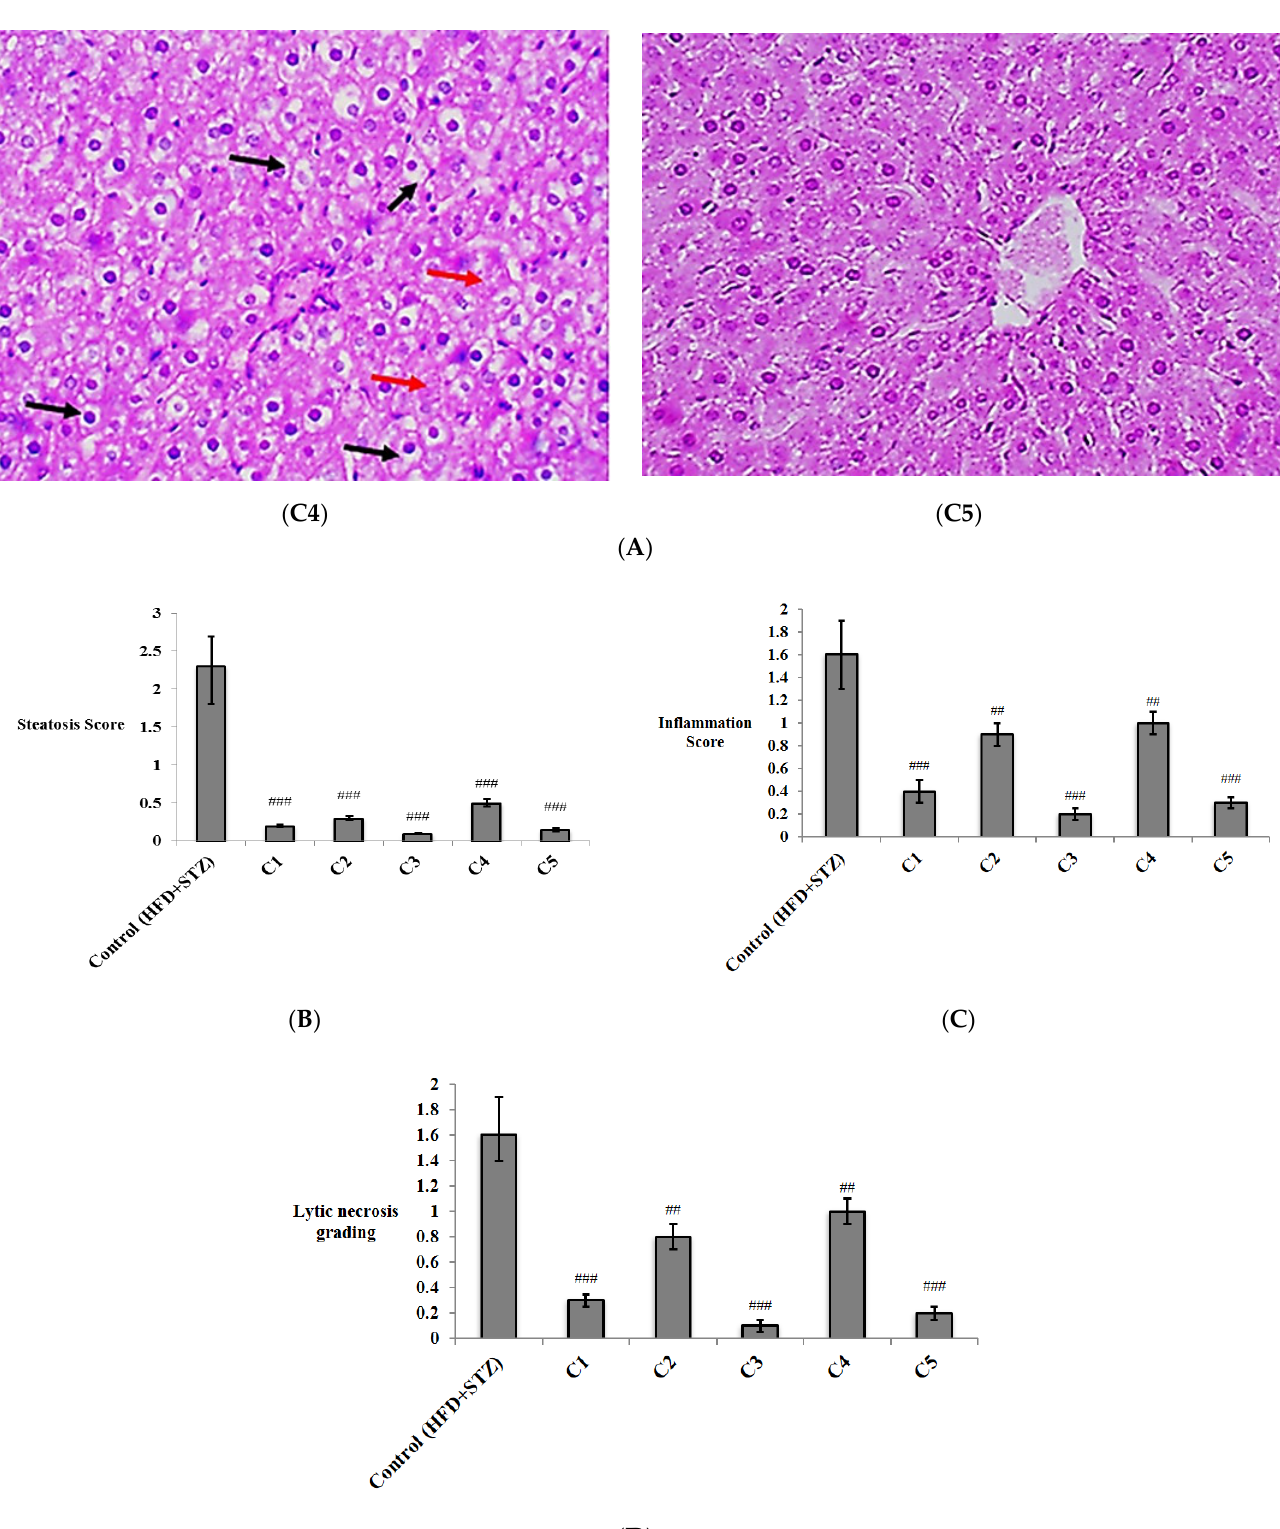
Figure 5. The histopathological study of hepatic tissues from different study groups. ( A ) Photomicrographs of hepatic tissues from different experimental groups stained by hematoxylin and eosin (H&E) and examined with magnifying power (40×). HFD + STZ control group showed hepatocytes with micro-vesicular steatosis (arrow heads), as well as macro-vesicular steatosis (yellow arrow). There were scattered foci of lytic necrosis of hepatocytes (red arrows) (H&E, 40×). ( C1 ): Rutin-treated group showed uniform hepatocytes with no evidence of injury (H&E, 40×). ( C2 ): Quercetin 3-O-